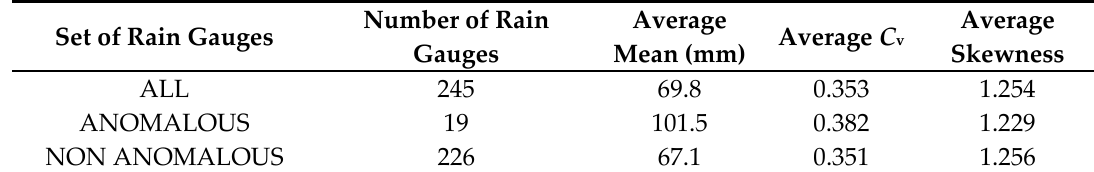
Table 2. Statistics of the data in the study area, with distinction among the whole dataset, the anomalous subset and the remaining rain gauges [7].